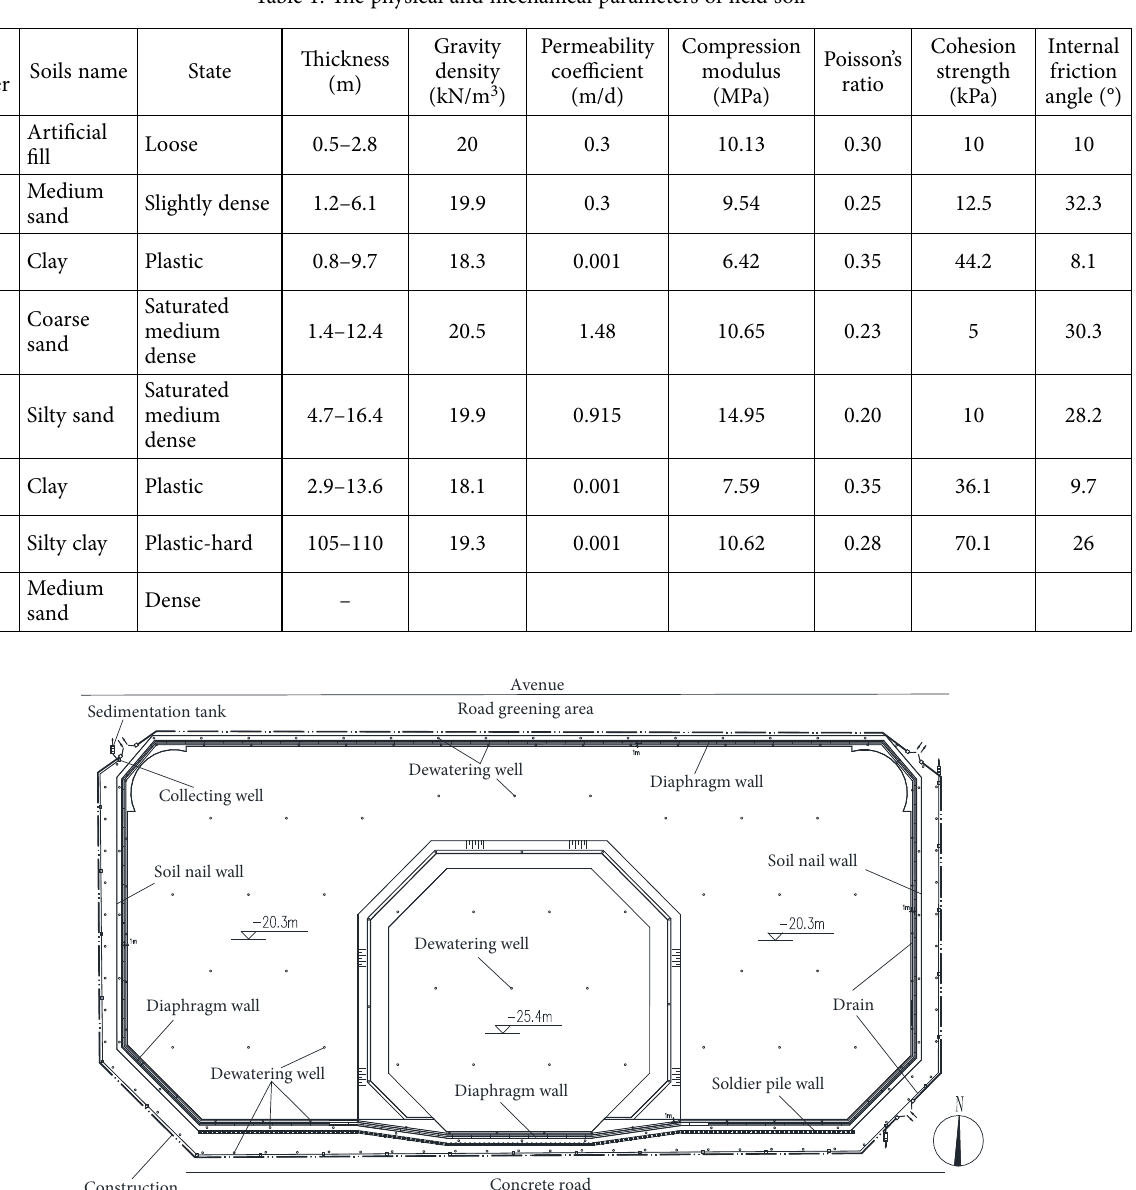
Table 1. The physical and mechanical parameters of field soil